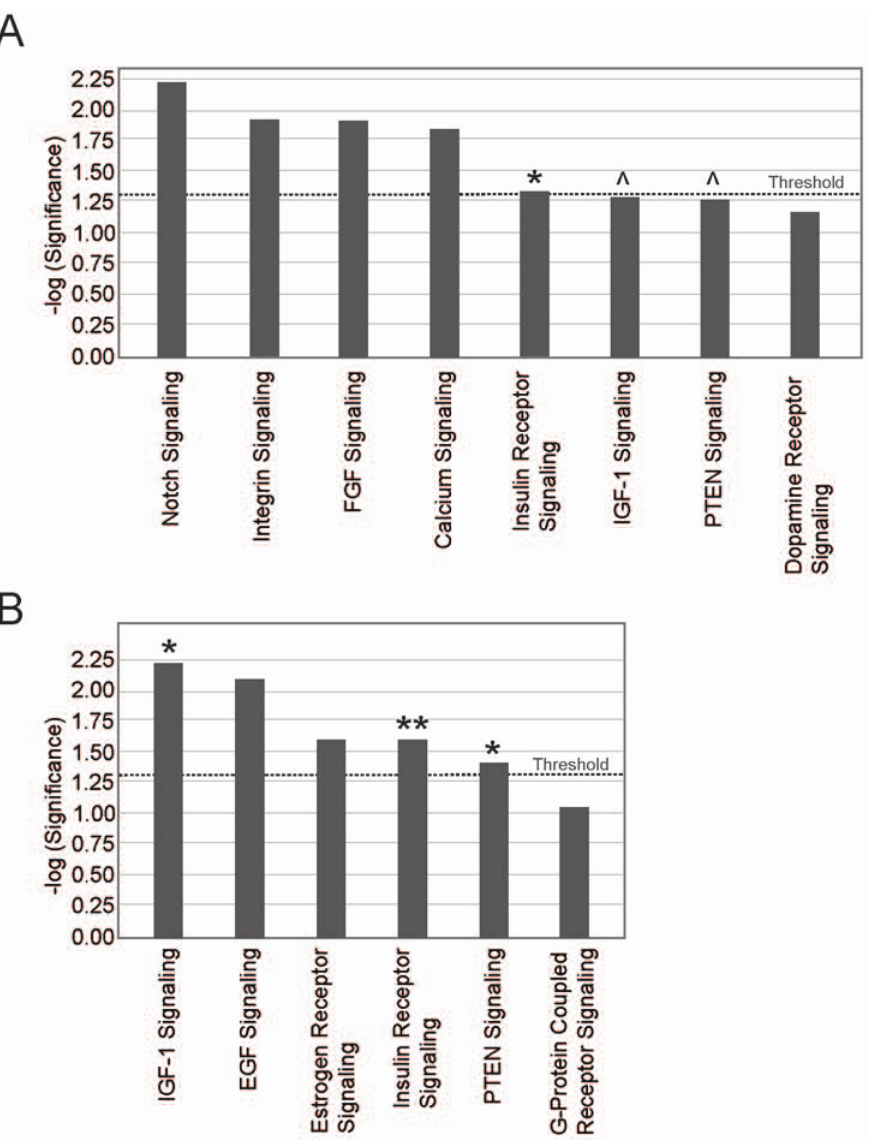
Figure 3. Significantly changed canonical pathways in PSP brain. Figure 3A. Significantly changed canonical pathways in PSP brain in the uncorrected dataset. Threshold for significance is shown in the dotted line. * signifies the significantly deregulated (p=0.047) Insulin Receptor Signalling pathway andˆ signifies the almost significantly deregulated (p=0.051 and p=0.055) IGF-1 and PTEN Signalling pathways respectively. Figure 3B. Significantly changed canonical pathways in PSP brain in the corrected dataset. Threshold for significance is shown in the dotted line. ** signifies the significantly deregulated (p=0.025) Insulin Receptor Signalling pathway for both analysis and * signifies the significantly deregulated (p=0.006 and p=0.039) IGF-1 and PTEN Signalling pathways,